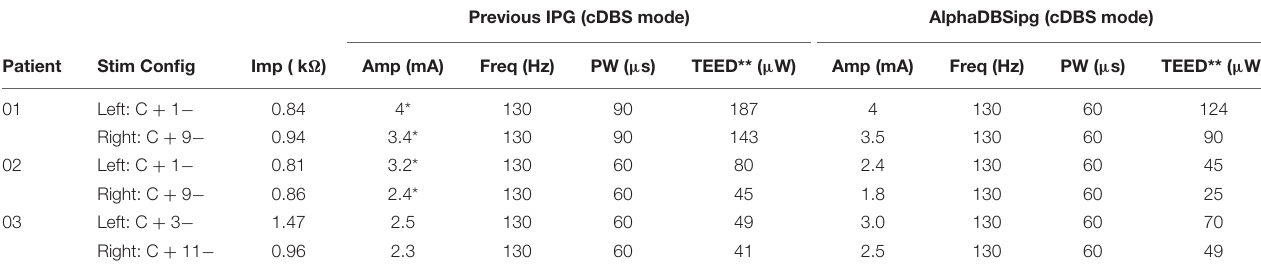
TABLE 2 | Parameter setting